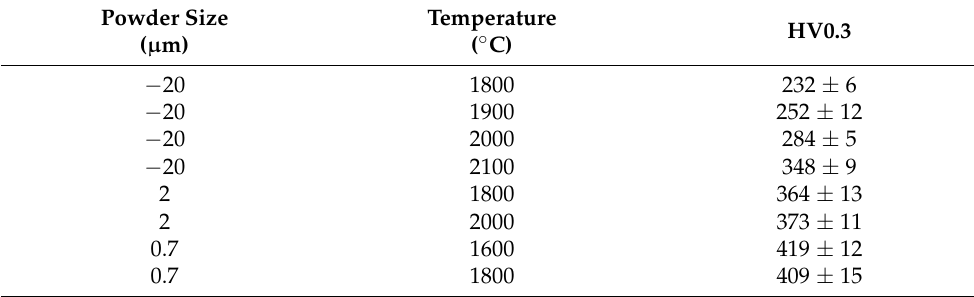
Table 2. Vickers microhardness of selected tungsten samples.